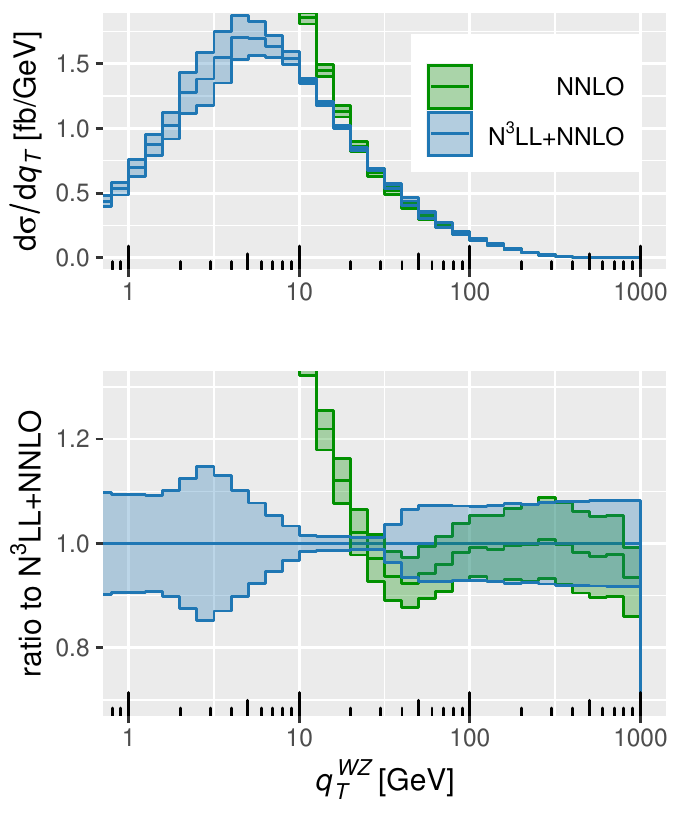
at 13 . 6 TeV using T